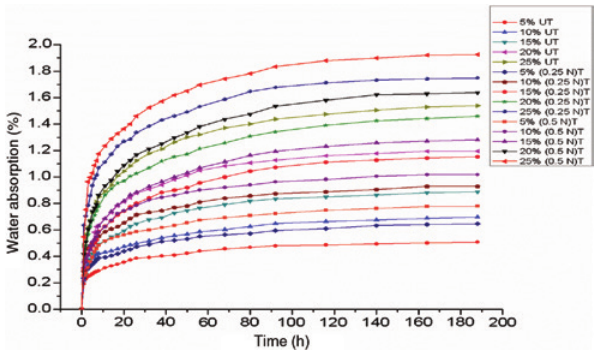
Figure 11: Water absorption behavior of untreated and treated HF/ HDPE